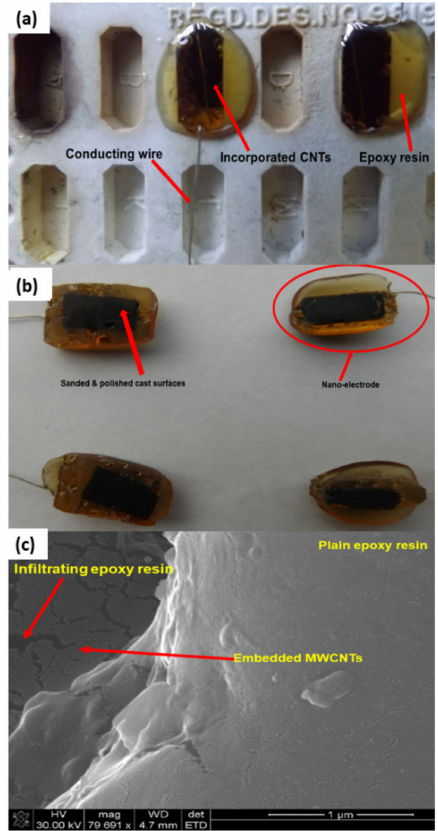
Figure 6. Incorporation of VA-MWCNTs in epoxy resin. Silicone rubber moulds for casting epoxy resin ( a ). Four sanded and polished nanoelectrodes ( b ). Epoxy resin with incorporated MWCNTs ( c ). CNTs are forming bundles in a vertical array (dark grey smooth surface), and the spaces between them are filled up with epoxy resin (dark cracks). The epoxy resin without CNTs is seen as a light grey solid lump without cracks ( c